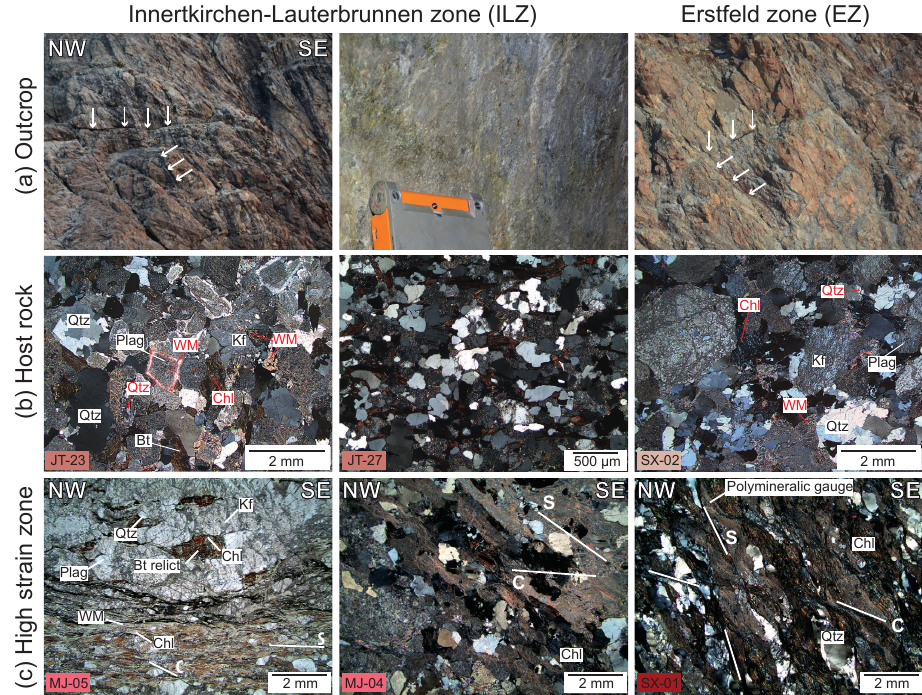
Figure 3. Key basement rock fabrics. (a) Outcrop images with indication of discrete shear zones (white arrows). (b) Crossed polarized light micrographs of pre-Alpine fabrics with relict granoblastic microstructures of large feldspar and biotite crystals, and interstitial quartz. Metamorphic overprint manifests in (i) white mica and quartz growth with smaller grain sizes, (ii) the alteration rims of feldspar and (iii) biotite to chlorite alteration (minerals from overprint are marked in red). Note the highlighted core-rim structure stemming from feldspar sericitization. (c) Shear zone micrographs. SC: fabrics are formed by white mica, chlorite and polymineralic fine-grained ultracataclasite or ultramylonite in between porphyroclasts (which exhibit brittle deformation). Mineral abbreviations – Bt: biotite, Chl: chlorite, Kf: alkali feldspar, Plag: plagioclase, Qtz: quartz, WM: white mica. Sample names are indicated; for sample details, see Table A1.